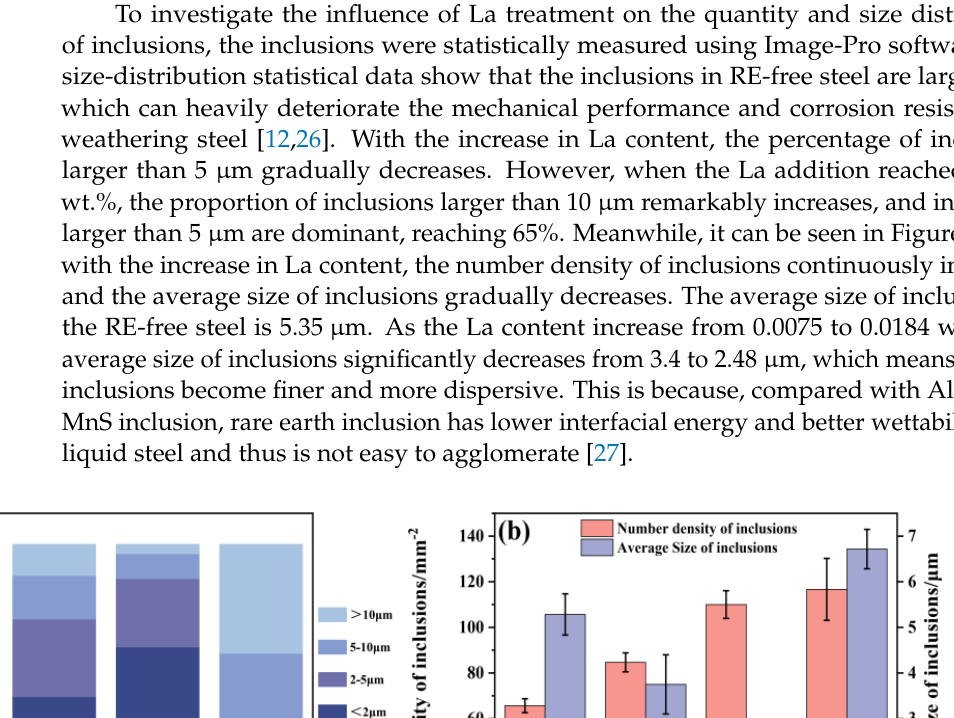
Figure 4. SEM images and EDS results of typical inclusions in steel containing 0.0425 wt.% La: ( a ) La 2 O 3 , ( b ) La 2 O 2 S, and ( c ) La 2 O 2 S-La 2 O 3 complex inclusion.